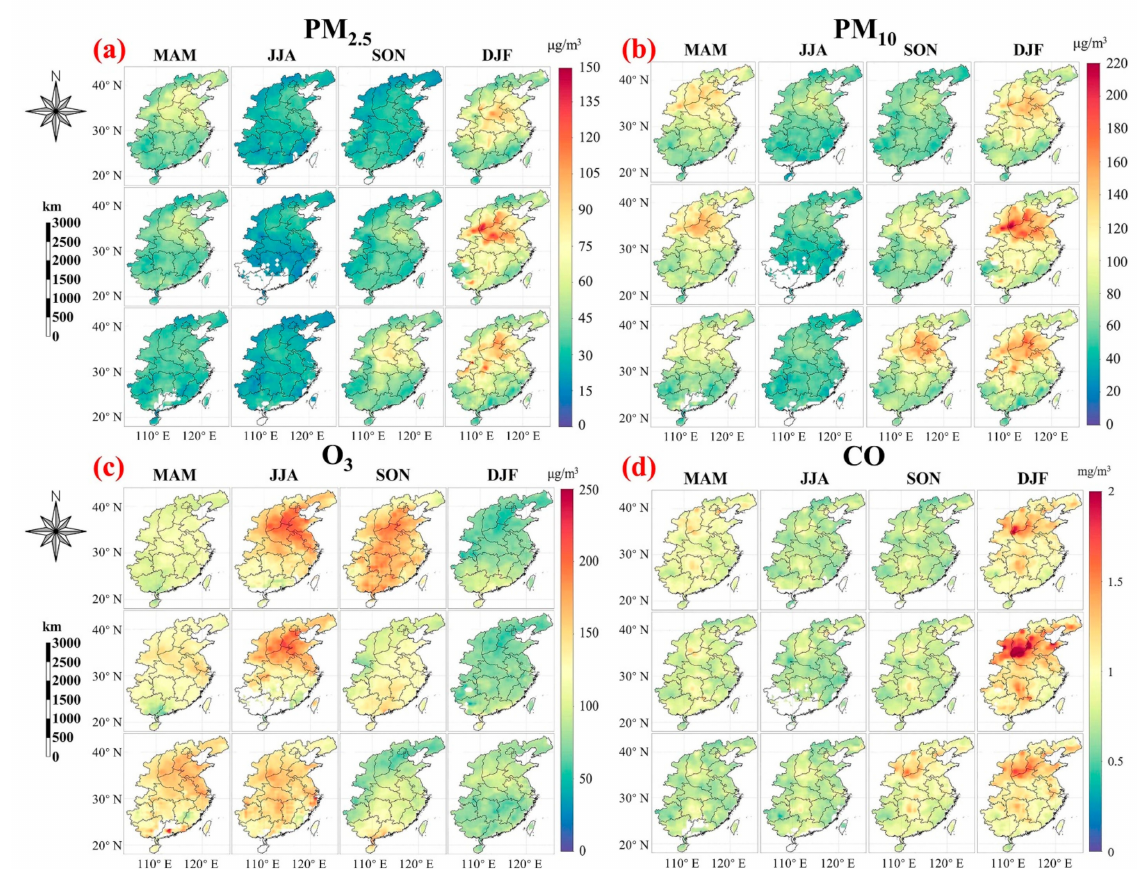
Figure 7. Seasonal spatial distributions of model-predicted PM 2.5 , PM 10 , O 3 , and CO concentration averaged from 2018 to 2019 over the central and eastern China. ( a ) PM 2.5 ; ( b ) PM 10 ; ( c) O 3 ; ( d ) CO. White area indicates no